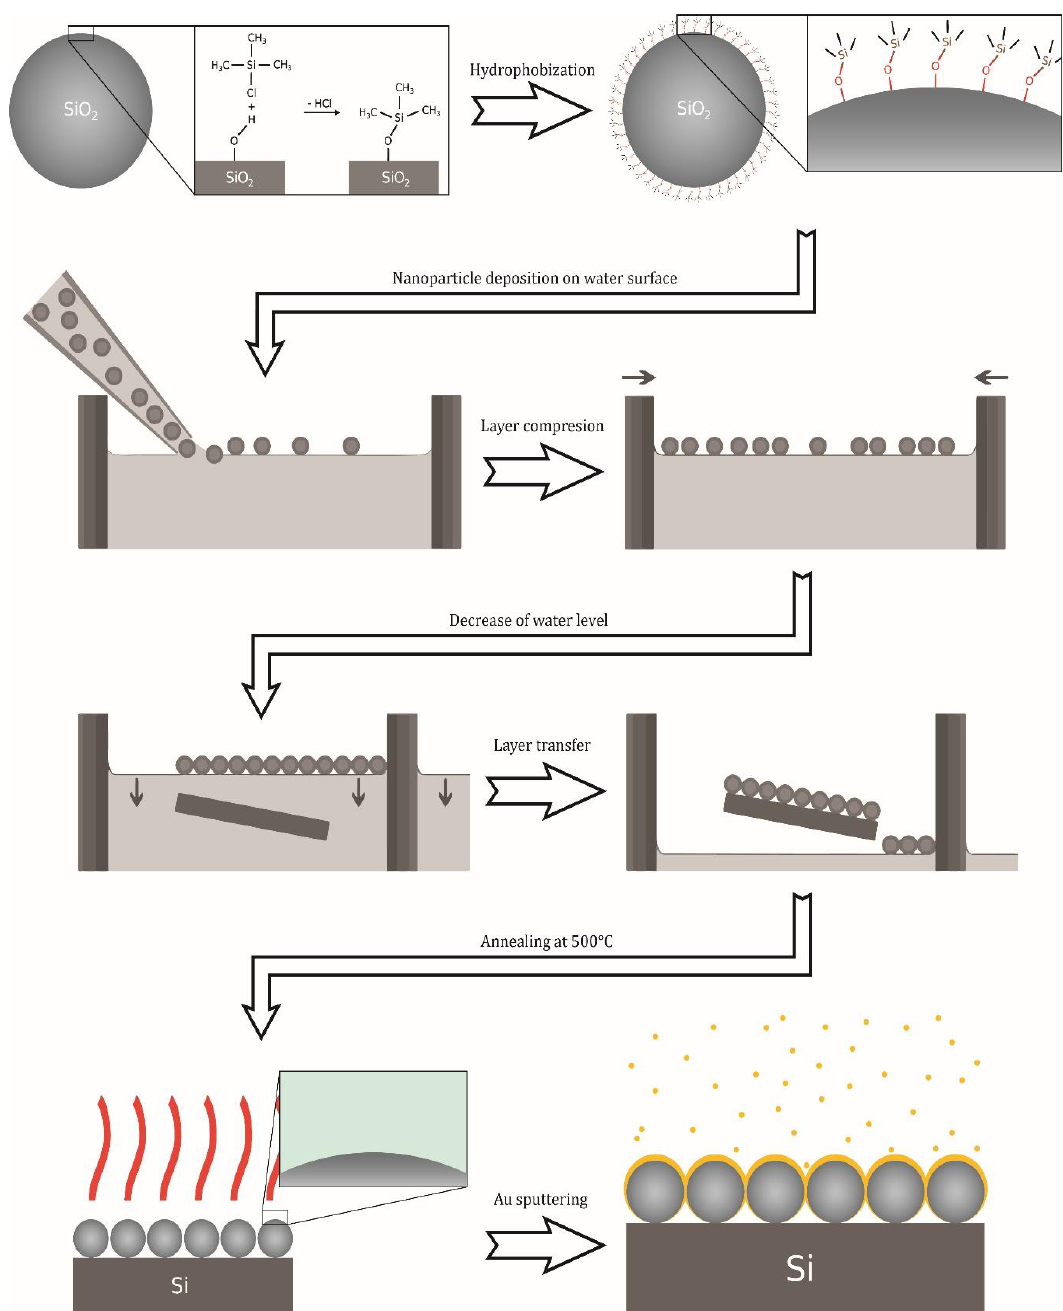
Figure 1. Schema of preparation procedure of AuSiO 2 substrates.